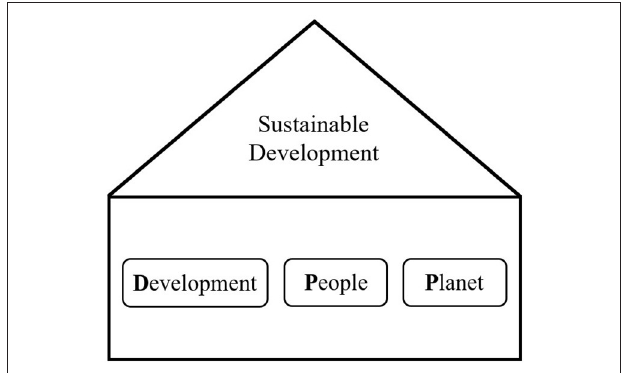
FIGURE 3 | The development, people, planet dimensions of sustainability (adapted from Kaptein and Wempe, 2002; van Marrewijk, 2003, p.